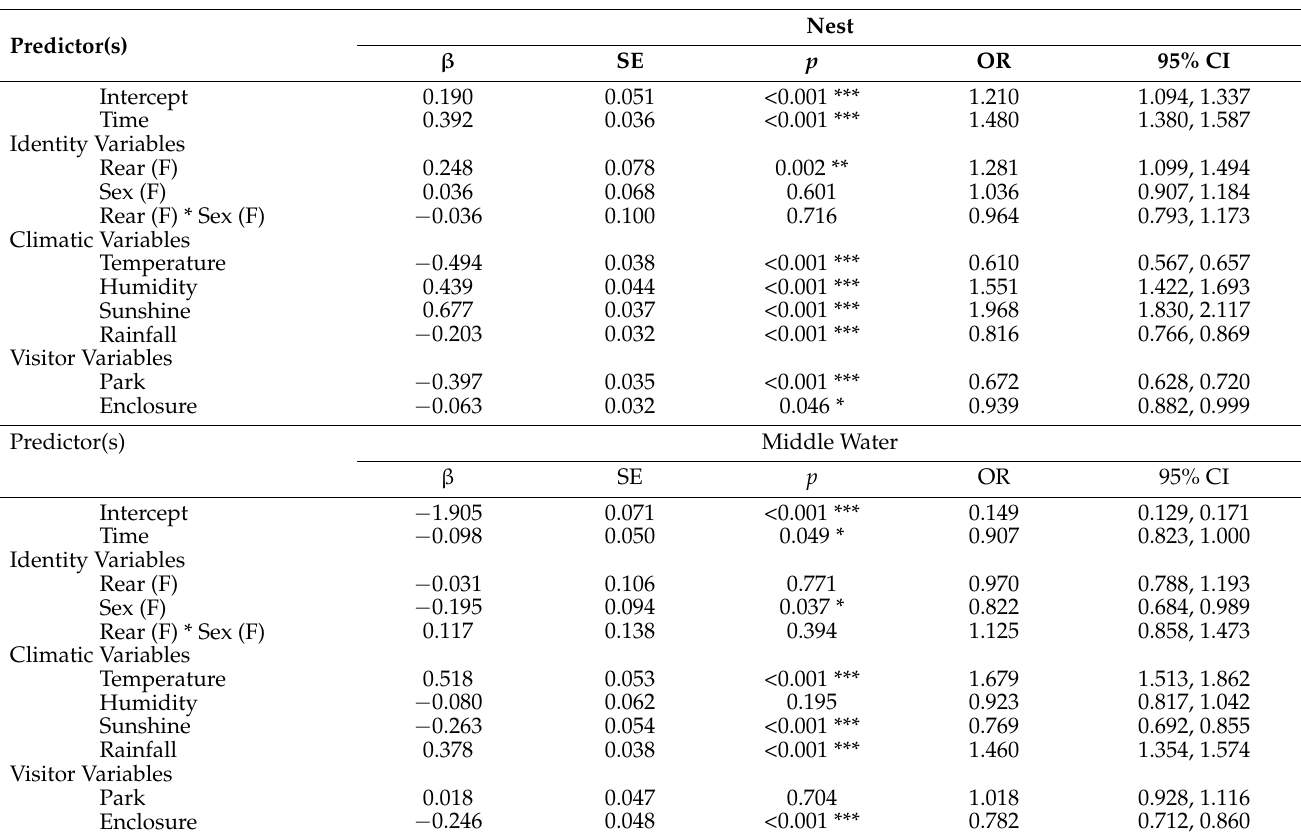
Table A4. FC binomial GLMMs investigating the influence of predictors of occupancy in key enclosure zones.